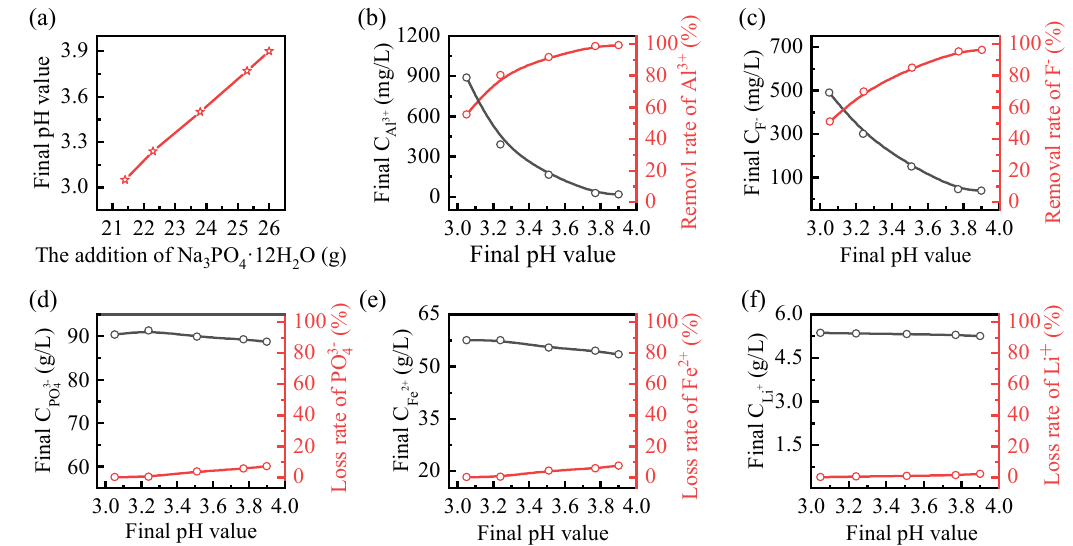
Figure 4. Effects of ( a ) Na 3 PO 4 · 12H 2 O dosage on the final pH value and precipitation behavior of ( b ) Al 3+ , ( c ) F − , ( d ) PO 43 − and ( e ) Fe 2+ and ( f ) Li + .